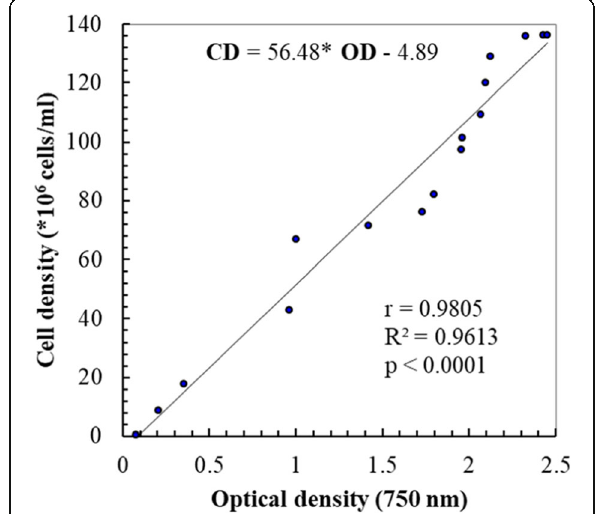
Fig. 5 Relation between cell density and optical density of Chlorella sp.